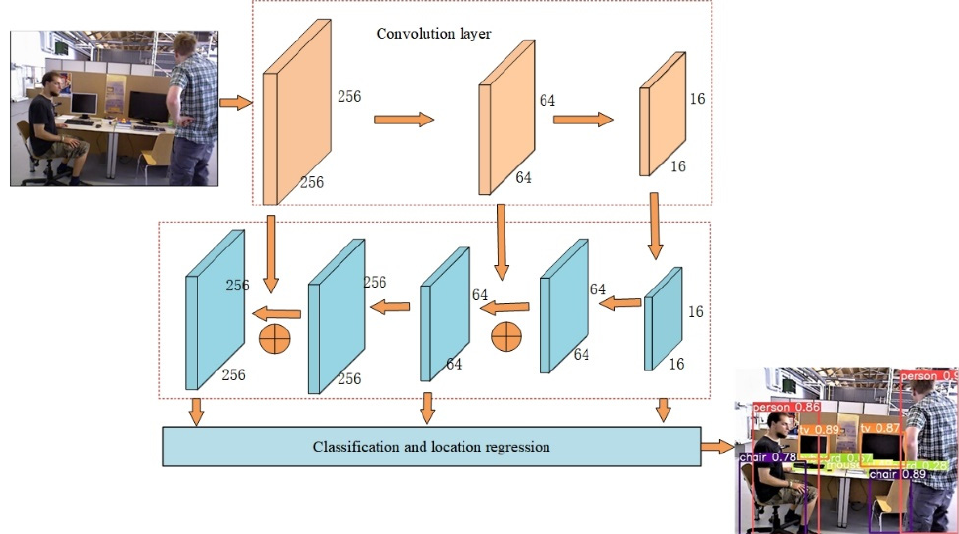
Figure 2. Structure principle of the YOLO algorithm.